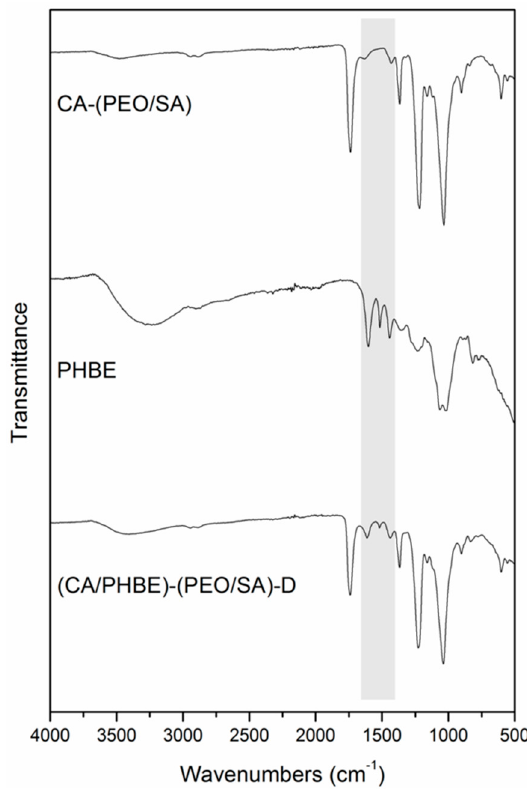
/ SA), PHBE and (CA / PHBE)-(PEO / SA)-D Figure 2. FT-IR spectra of CA-(PEO/SA), PHBE and (CA/PHBE)-(PEO/SA)-D patches. Figure 2. FT-IR spectra of CA-(PEO